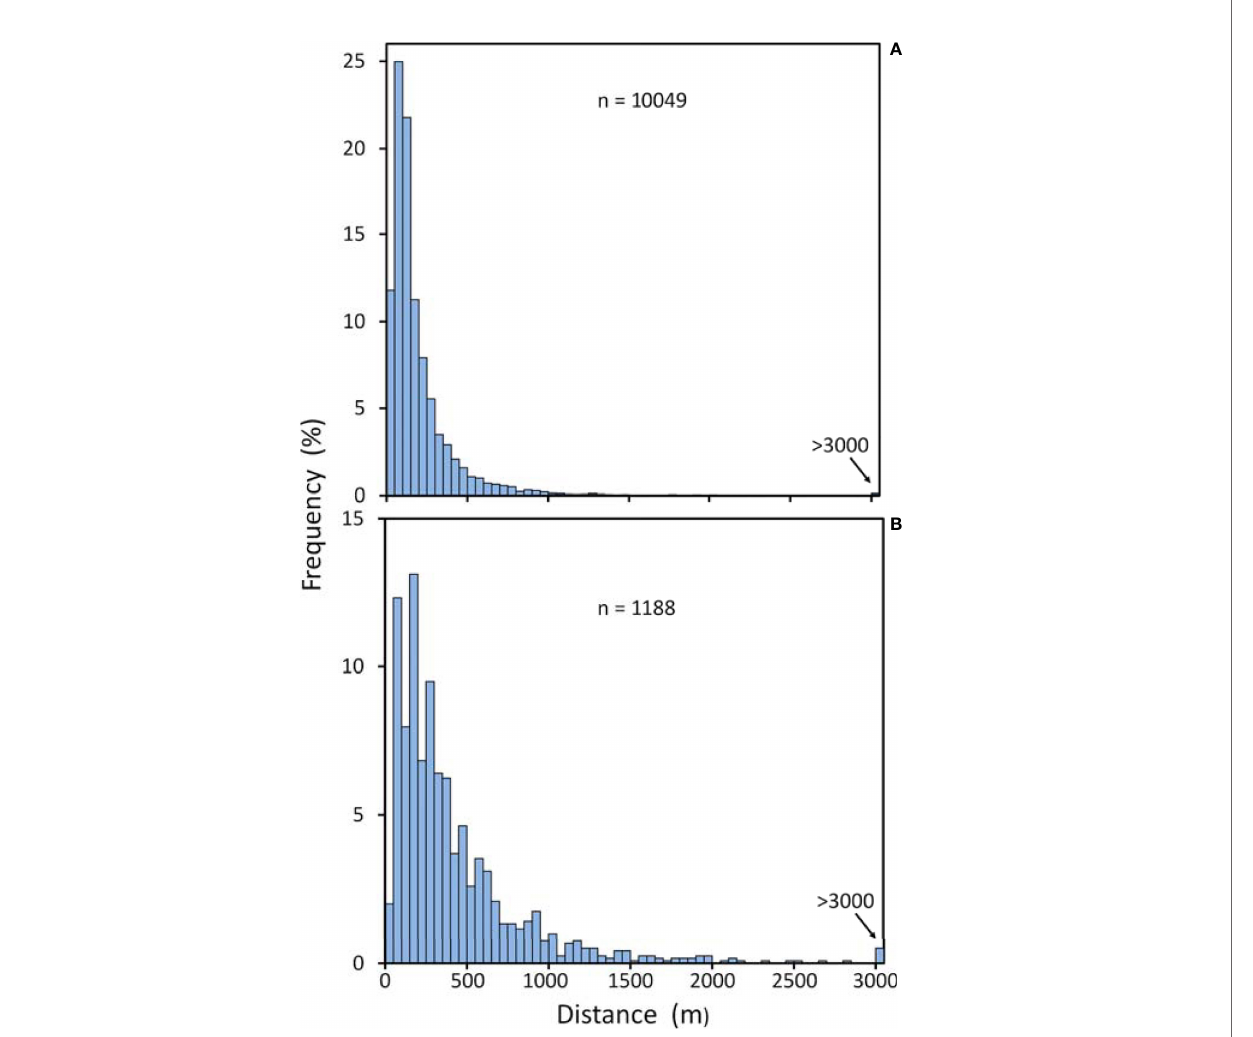
FIGURE 9 | Nearest neighbour distances between centroids of steep slope (>30°) patches from transects across at the MAR at 41.5°N to 56°N. (A) Data from the RV GO Sars (42-59m resolution). (B) Data from the RRS James Cook (99-100m